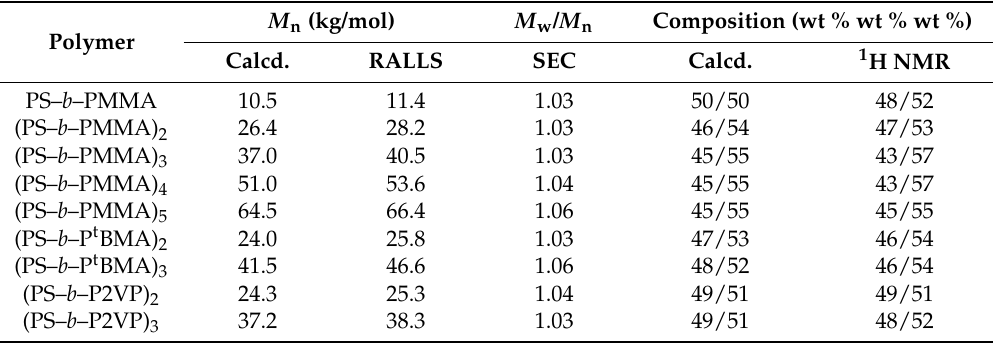
Table 11. Characterization results of (PS– block –PMMA) n , (PS– block –P t BMA) n and (PS– block –P2VP) n synthesized by the iterative